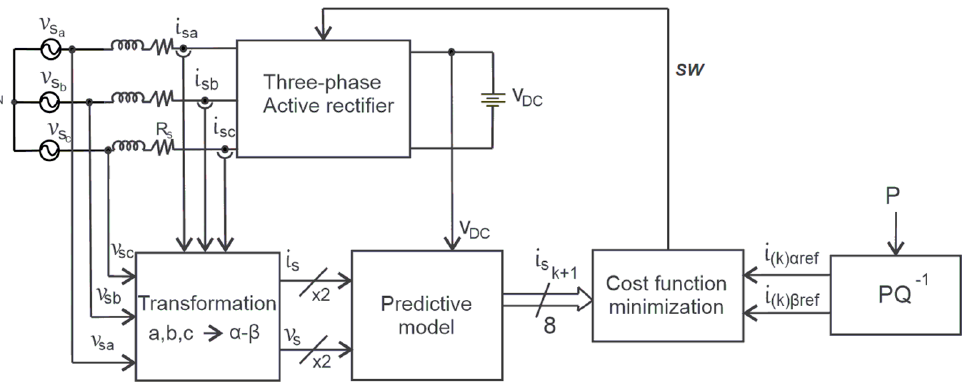
Figure 8. Predictive control scheme for the AC–DC converter.